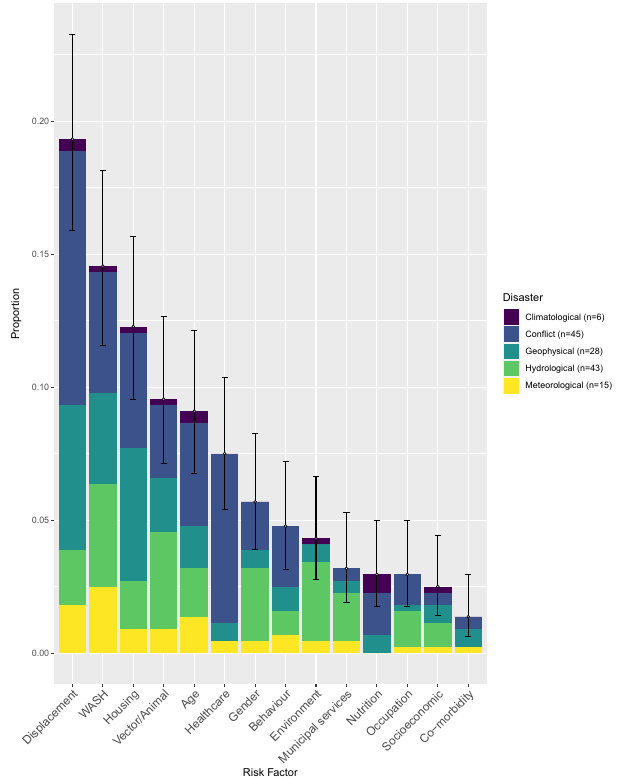
Figure 5. Proportions of the fourteen main risk factor clusters out of the 418 risk factors reported in the search results, against disaster, with binomial confidence intervals (95%). WASH—Water, sanitation &